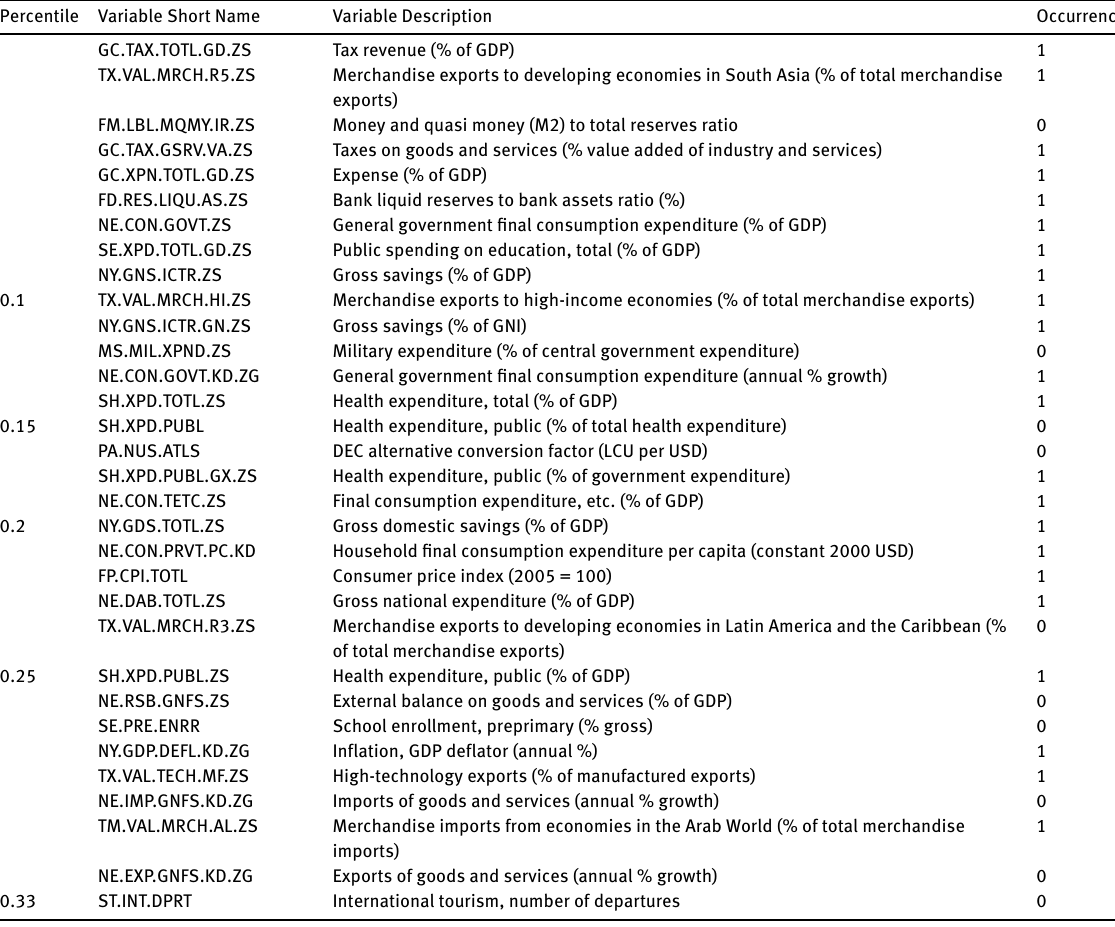
Table 7: List of most important variables within the stress/future state data and their occurrence in the estimated future state data. The variables are sorted in order of their importance score from most important to least important. The boundaries of the percentiles are indicated on the